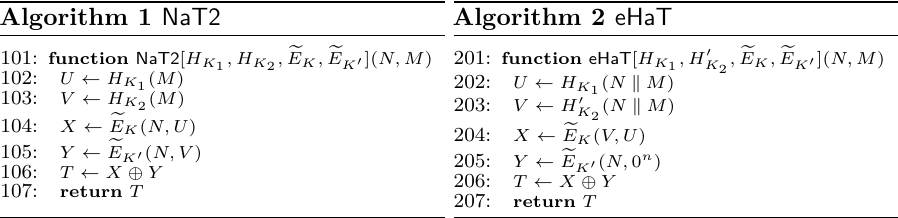
Figure 3: Our proposals, NaT2 and eHaT